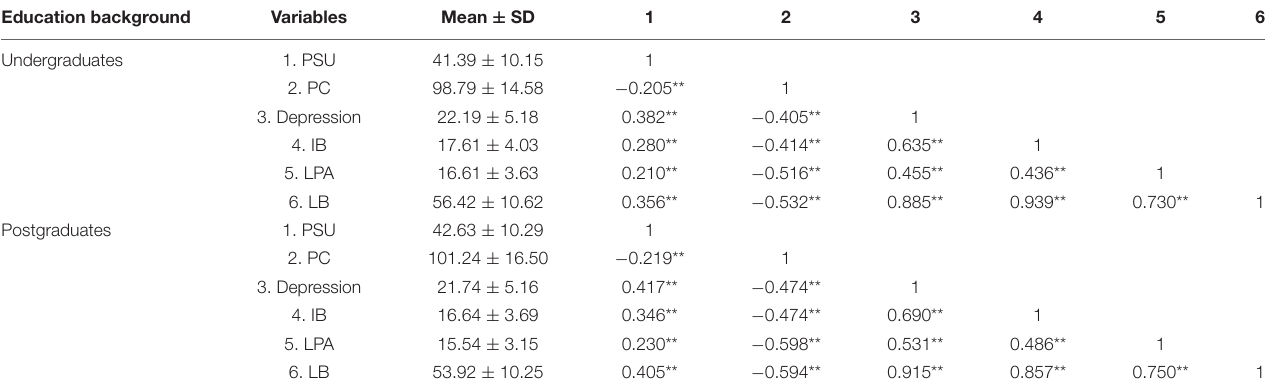
TABLE 2 | Correlation among psychological capital, problematic smartphone use, and learning burnout.